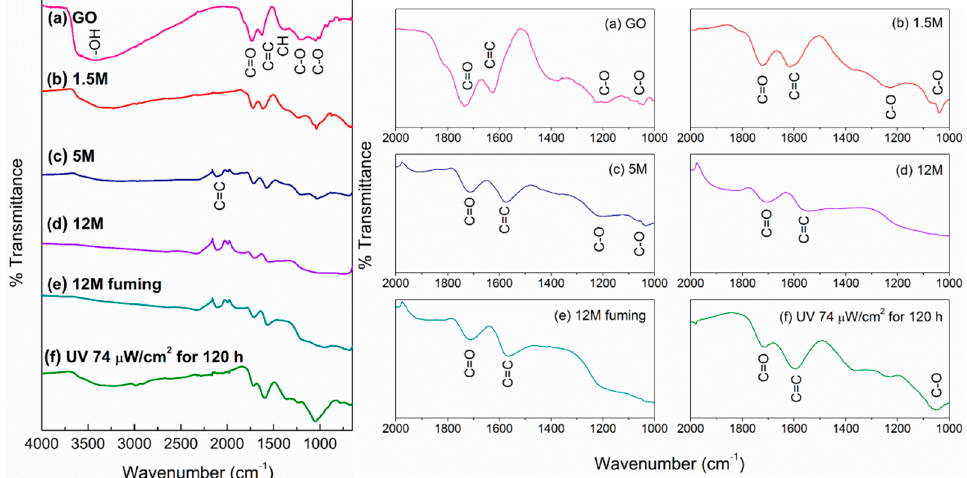
Figure 1. Infrared spectra ( left ) and details of the IR spectra from 2000 to 1000 cm − 1 ( right ) of ( a ) as-produced GO and RGO with H 2 SO 4 at ( b ) 1.5 M, ( c ) 5 M, ( d ) 12 M, ( e ) fuming H 2 SO 4 12 M, and ( f ) RGO irradiated at 74 μ W/cm 2 for 120 h.